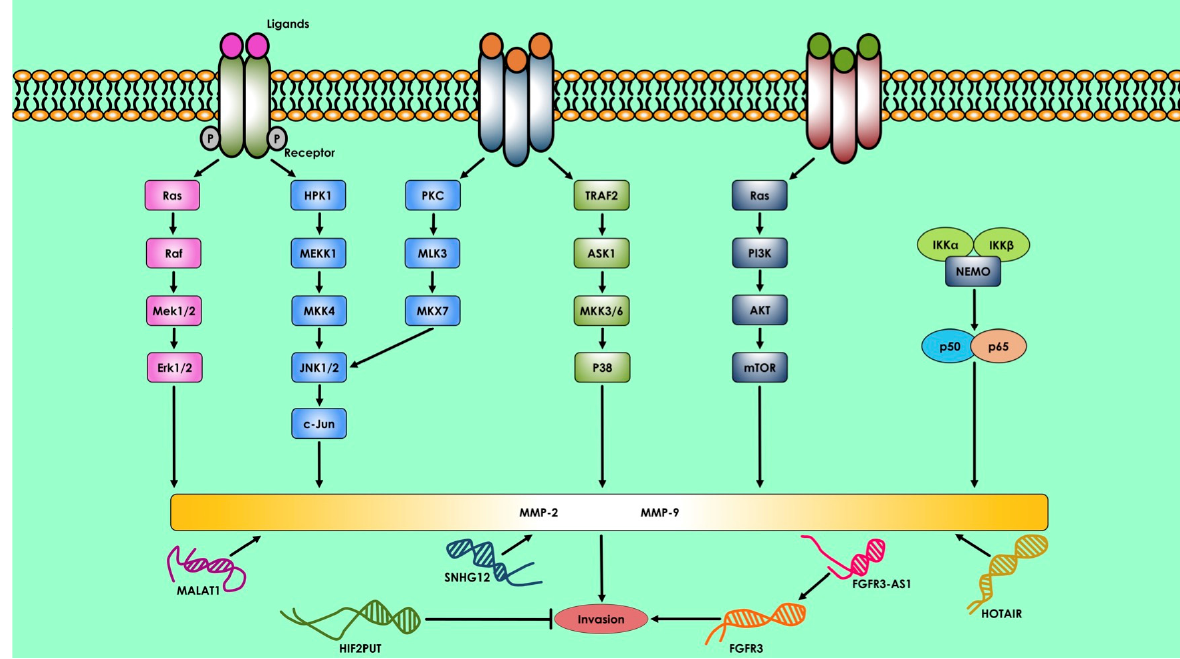
Figure 3. Long non-coding RNA that regulates osteosarcoma invasion and metastasis. MALAT1, SNHG12, HOTAIR, FGFR3-AS1, and HIF2PUT are lncRNAs that govern osteosarcoma invasion and metastasis. The Erk1/2, JNK1/2, P38, PI3K/Akt, and NF-B signaling pathways control MMP-2 and MMP-9 secretion. MMP-2 and MMP-9 govern osteosarcoma cell invasion. P50-associated COX-2 extragenic RNA (PACER), another lncRNA, is overexpressed